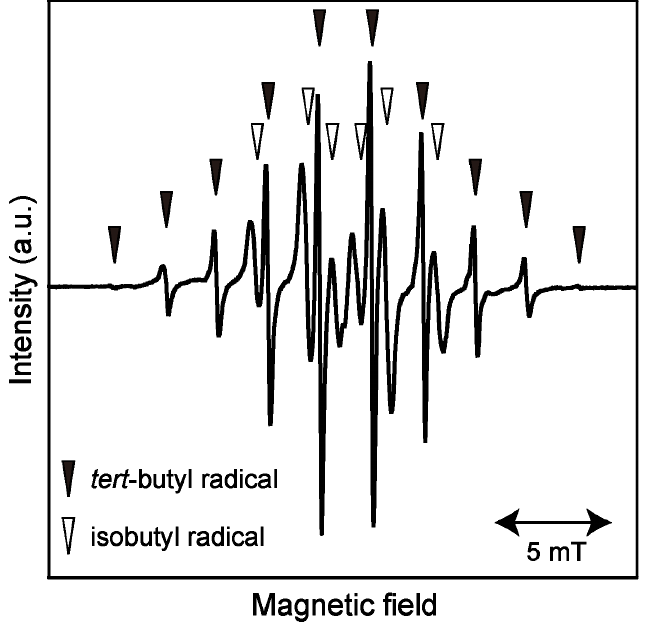
Figure 1. ESR spectrum of radicals induced in the γ -ray-irradiated isobutane hydrate O. The measurement was performed at 120 K and ambient prepared with D 2